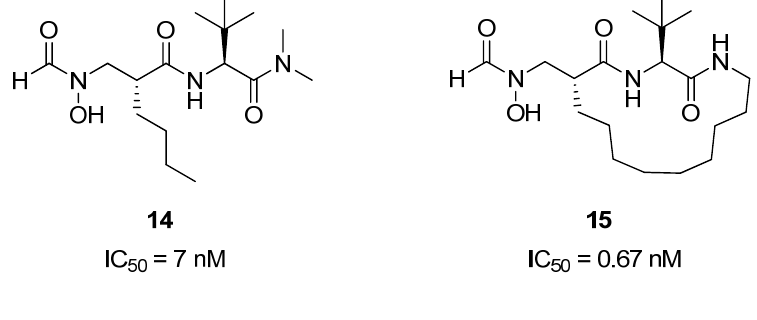
Figure 5. An RCM-derived conformational constraint improves the affinity of 14 for its target peptide deformylase roughly